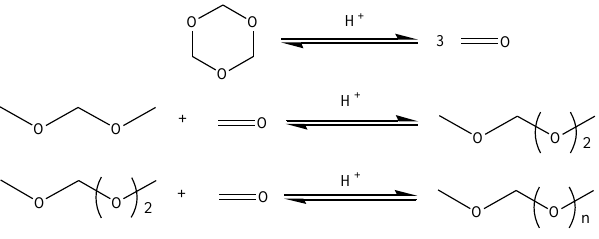
Figure 1. Reaction routes of polyoxymethylene dimethyl ethers (PODE n ) synthesis from dimethoxymethane (DMM) and trioxymethylene (TOM)